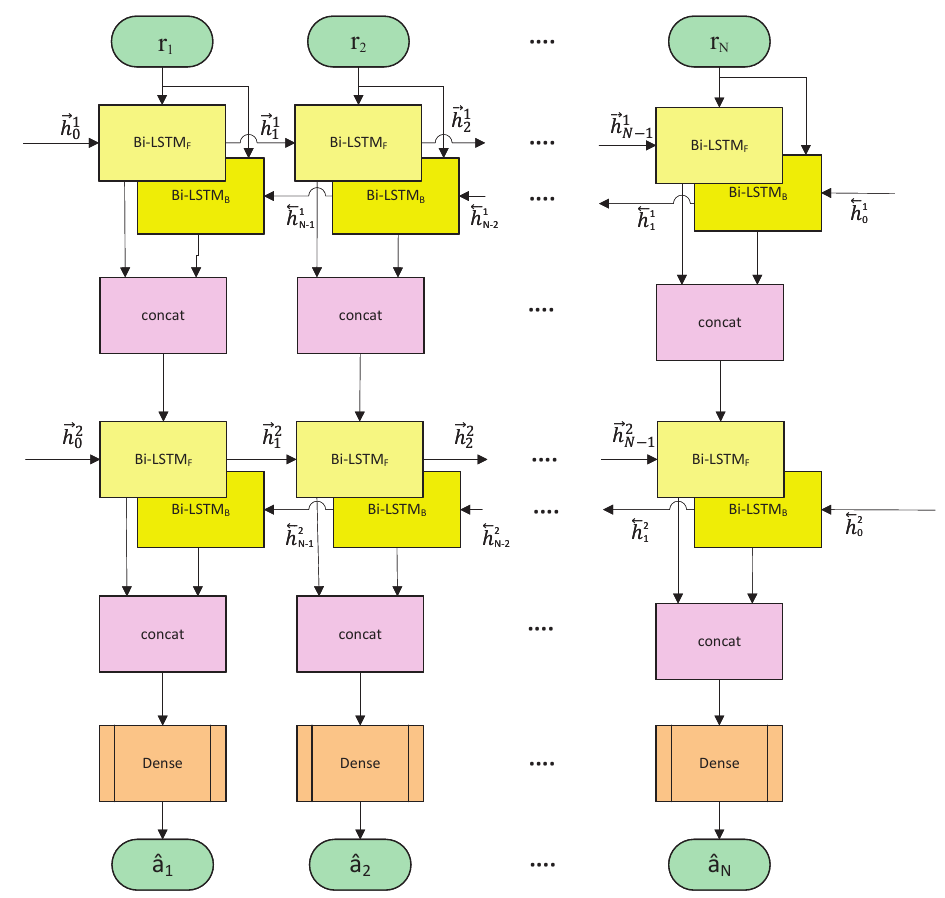
Figure 3. Block diagram of using CNN network structure to detect FTN